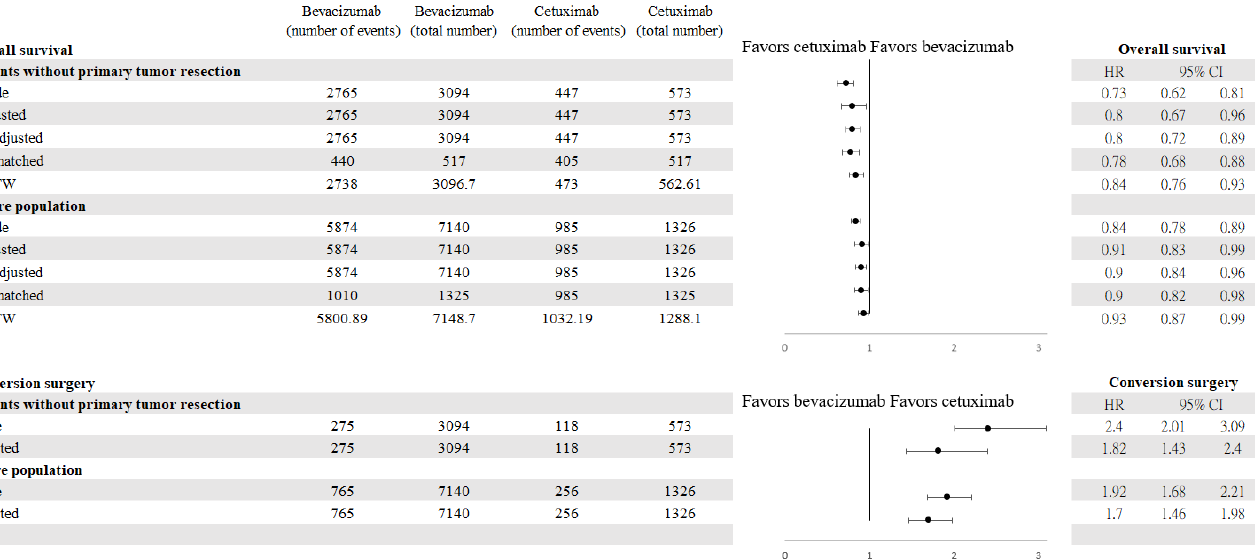
Figure 2. Kaplan–Meier survival curves for OS in mCRC in ( a ) patients without primary tumor re-